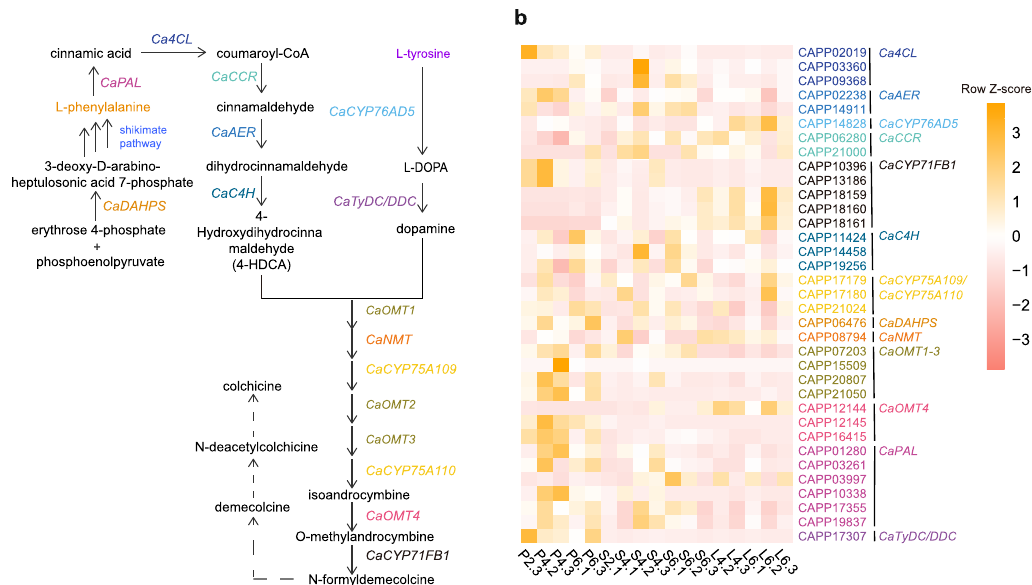
Fig. 4 Biosynthesis pathway of colchicine and the expression level of candidate enzymes in the pathway. a The colchicine biosynthesis pathway. b The expression level of colchicine-related genes in C. appendiculata genome. “ P ” : Pseudobulb, “ S ” : Stem, “ L ” : Leaf. 2: Two years old, 4: Four years, 6: Six years. “ .1, .2, .3 ” means sample duplications. Row Z -score means the normalization of FPKM values by the z -score method of each row. Yellow color represents a high expression level, and pink color represents a low expression